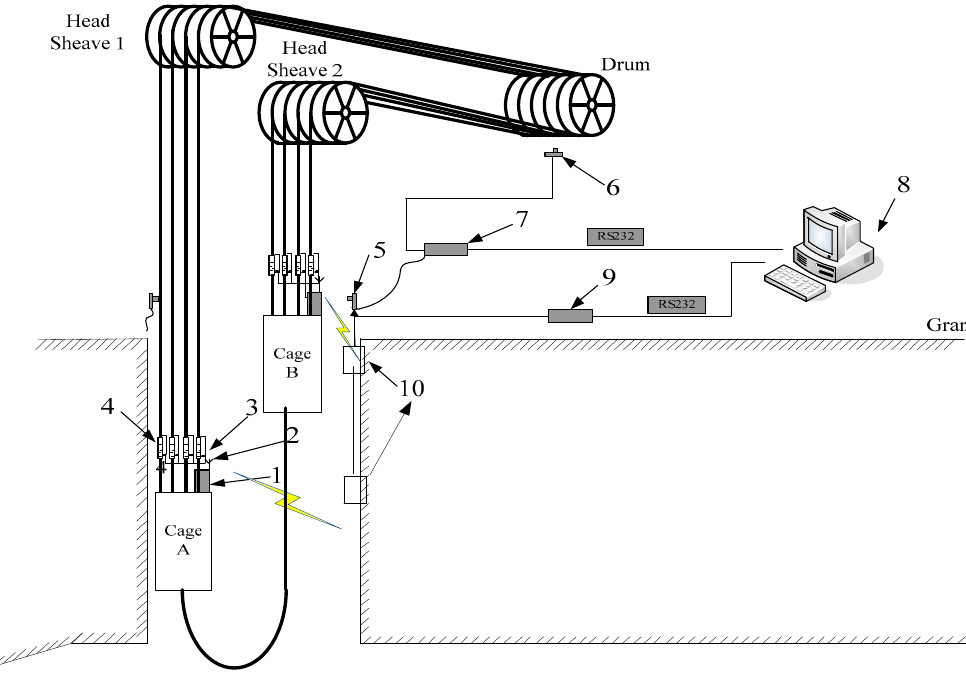
Figure 1. Schematic diagram of tension monitoring system for a multi-rope hoist.